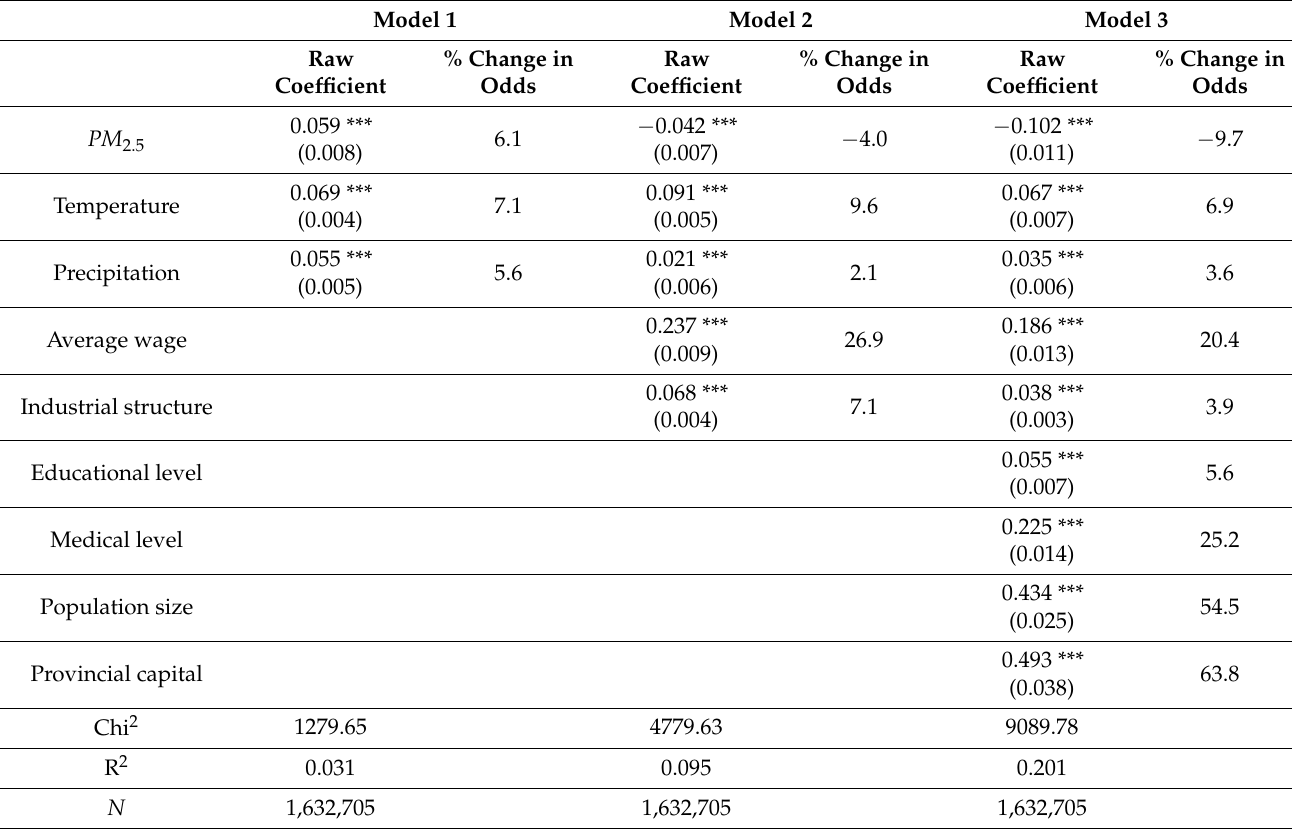
Table 2. Conditional logit regression without using